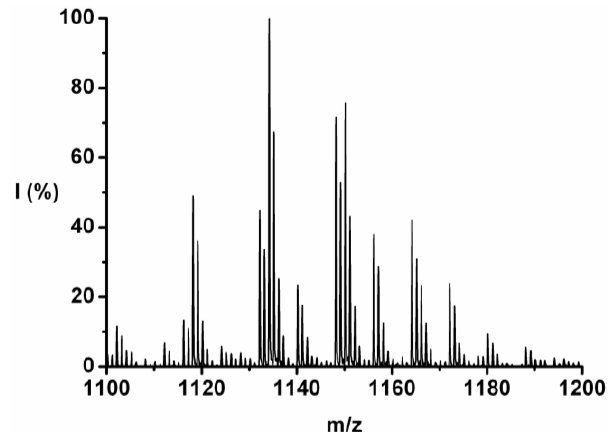
Figure 3. MALDI-ToF mass spectrum of poly(Tyr-co-Phe) zoomed in on the 7-mer.